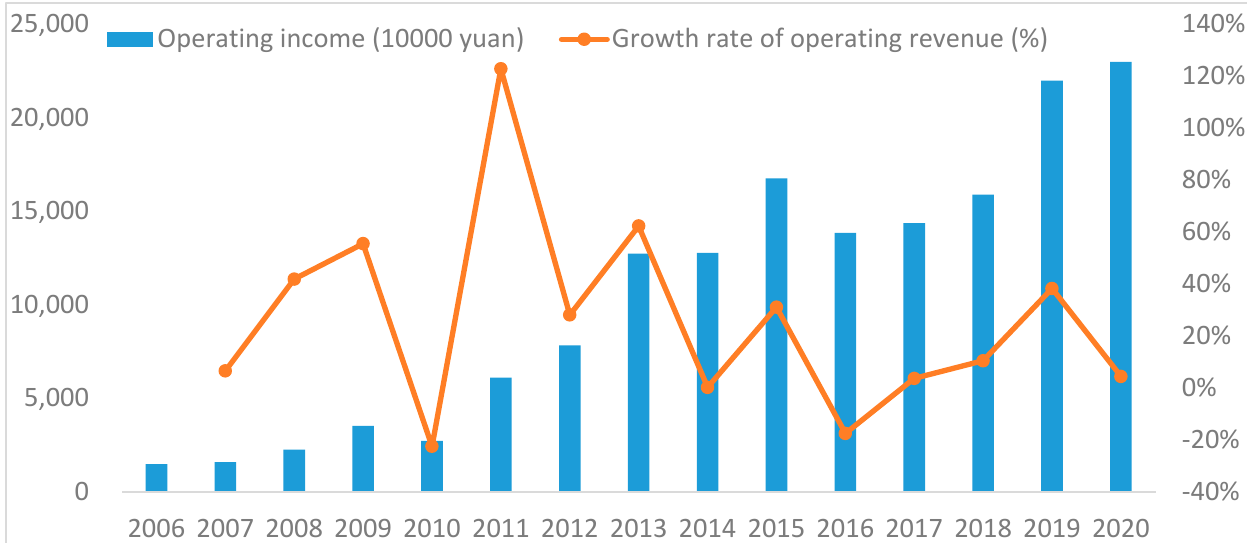
Figure 4. Analysis on the operating income change of DK company.